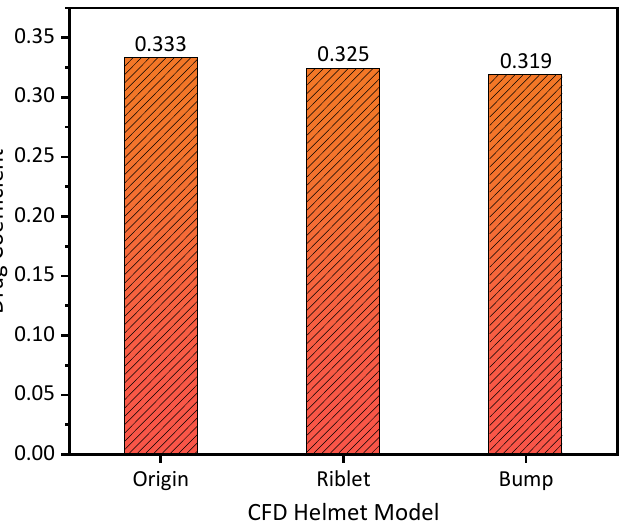
Figure 10. Drag coefficient of the results for three types of helmets used in the CFD simulations.